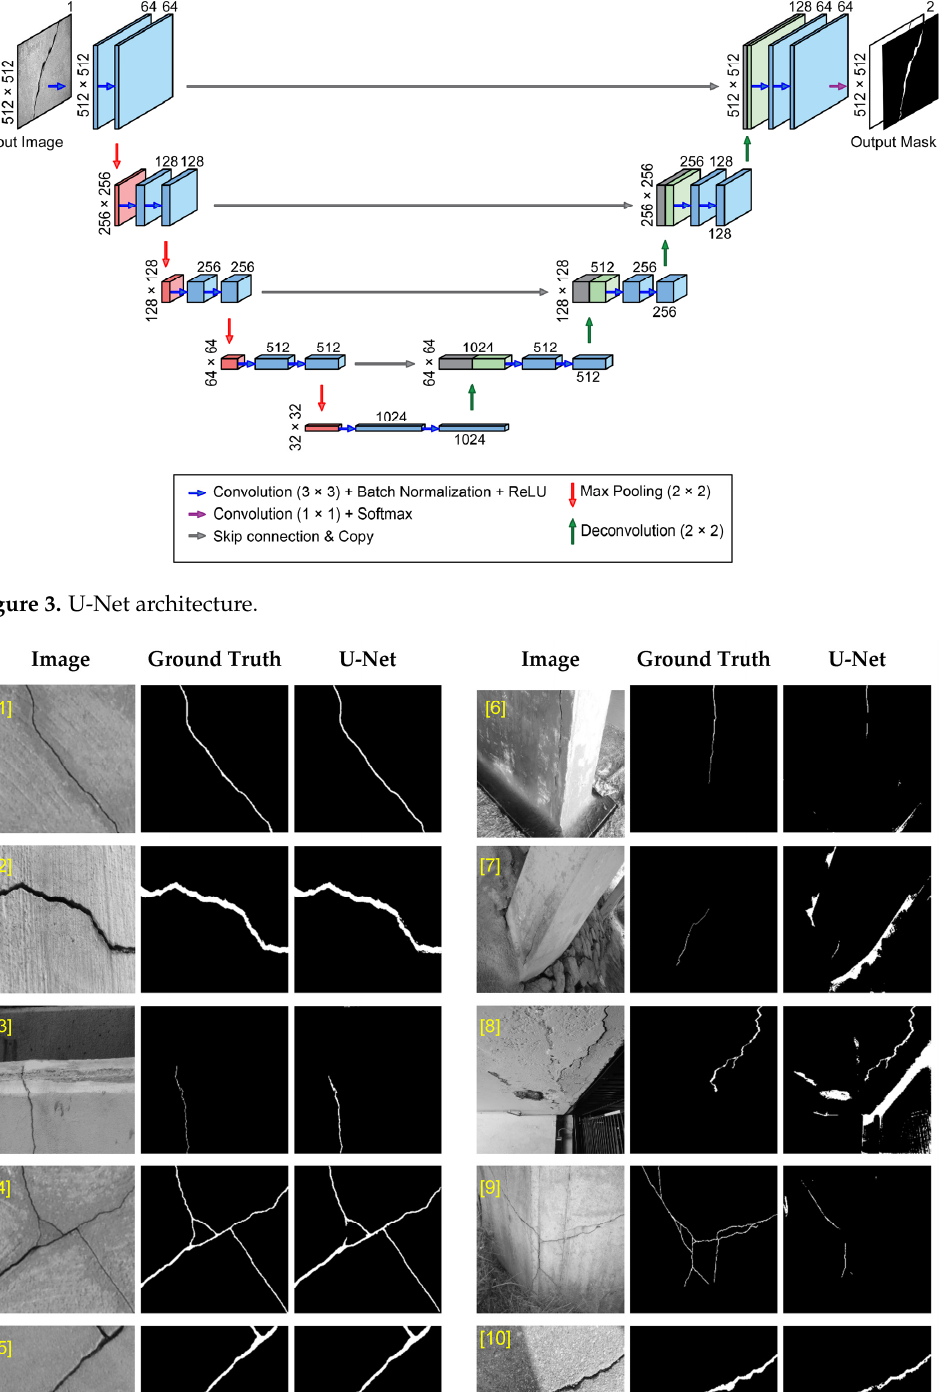
Figure 5. Distribution of crack-to-area ratio in the public dataset of 540 images.